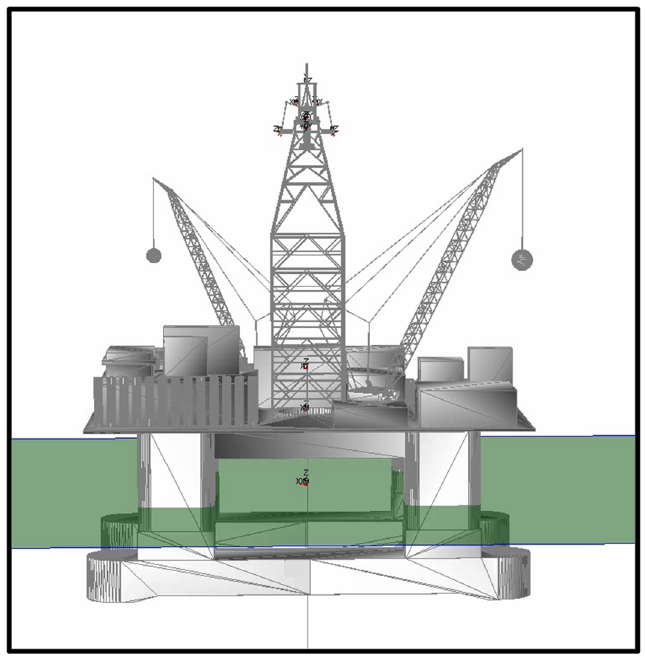
Figure 12. Visualization of the dynamic response of the heave compensation system.